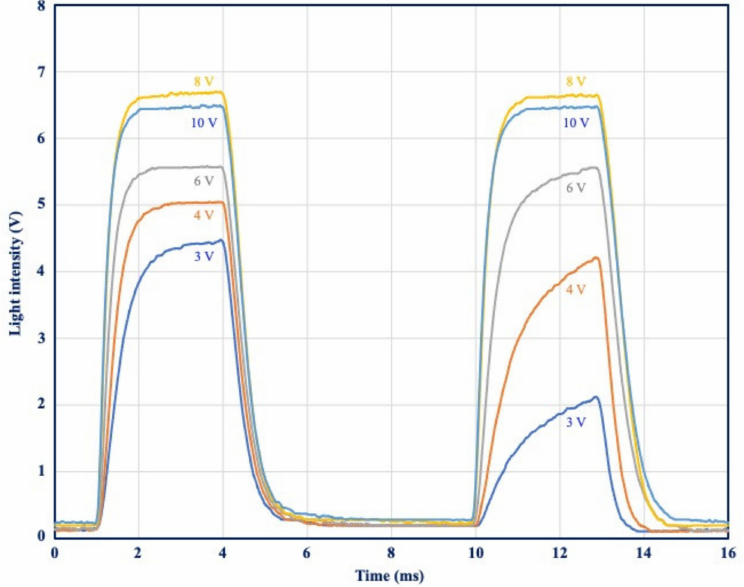
Figure 13. Applied pulse voltage dependence of light throughput of the expectedly heavily twisted stacked SSD-LC panel. Applied pulse voltage is a bipolar pulse with a 3 ms duration with a 5 ms zero voltage